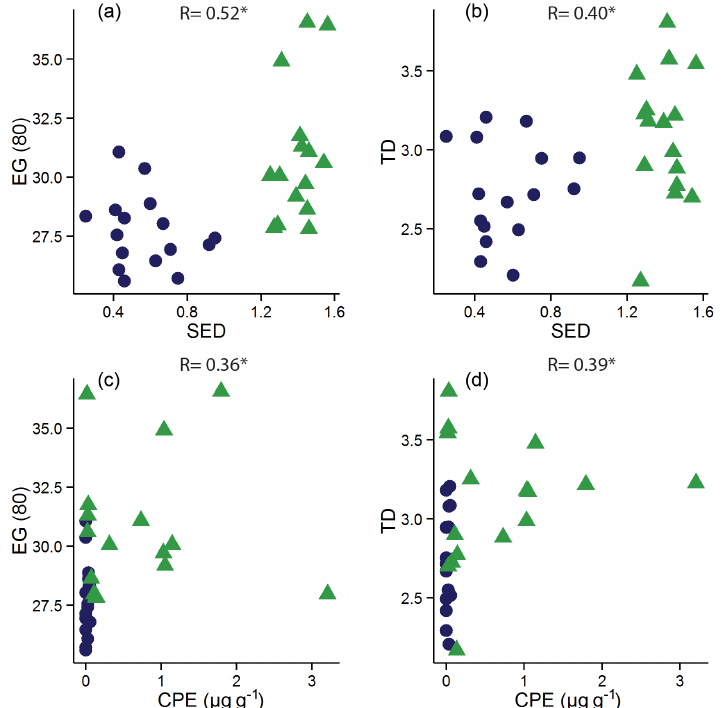
Figure 6. Correlations (a) between sediment particle-size diversity (SED) and expected genus diversity (EG (80)), (b) between SED and trophic diversity (TD), (c) between EG (80) and chloroplastic pigment equivalents (CPE), and (d) between TD and CPE. Green triangles represent correlations for shelf-break stations and dark blue circles between slope stations. R indicate correlation values of Spearman. ∗ shows significant correlations.